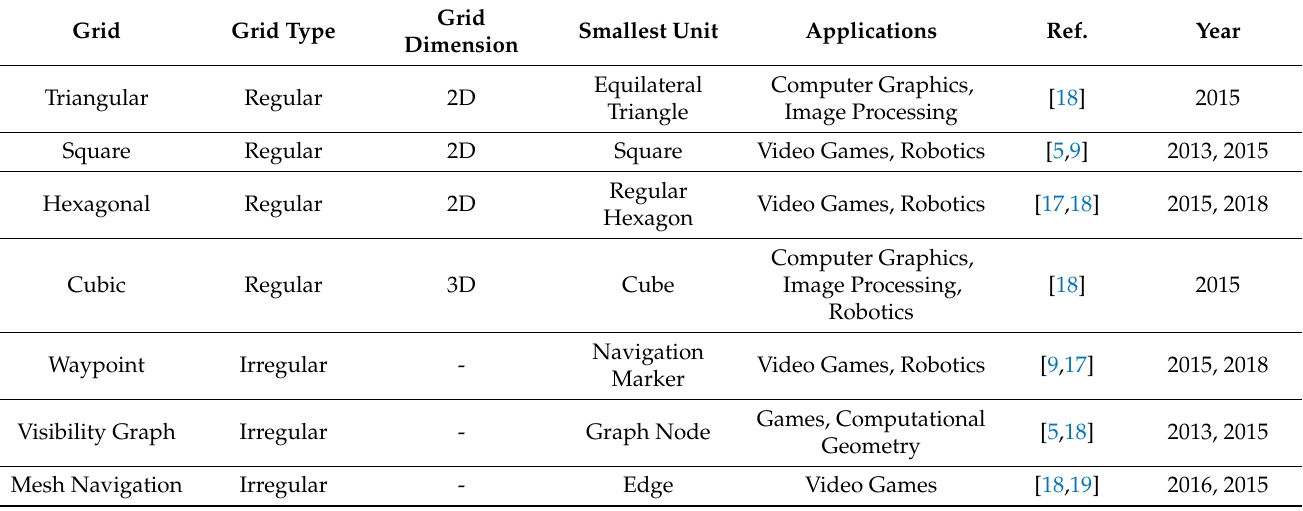
Table 1. Grid classification based on grid type, grid dimension, smallest unit, and